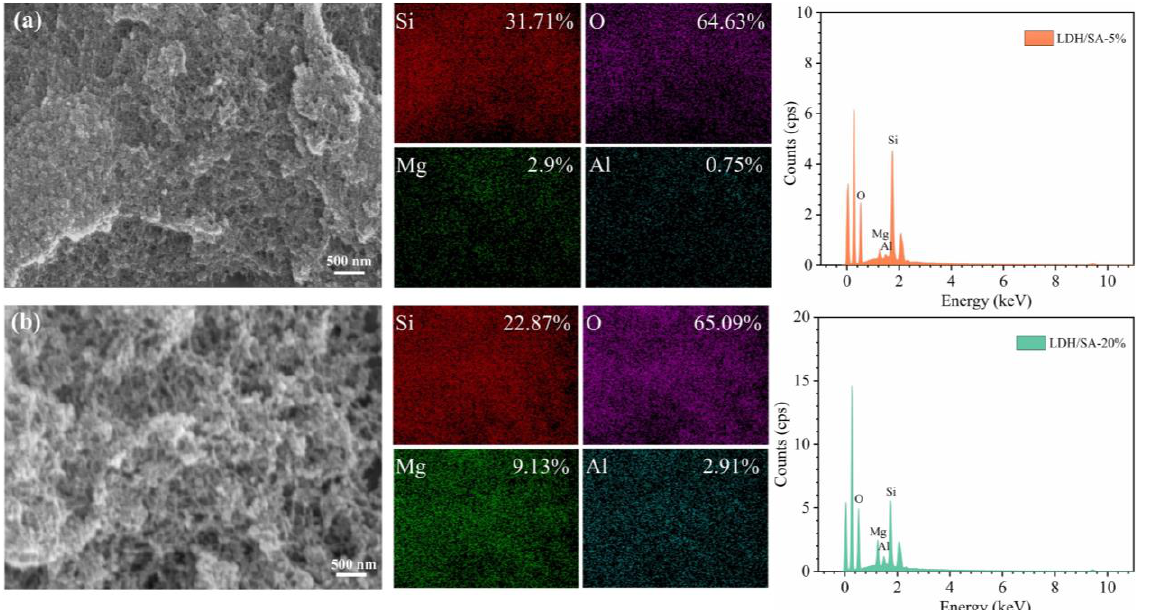
Figure 3. SEM images of MgAl-LDH ( a ), SA ( b ), and LDH/SA-5%~20% ( c – f ).